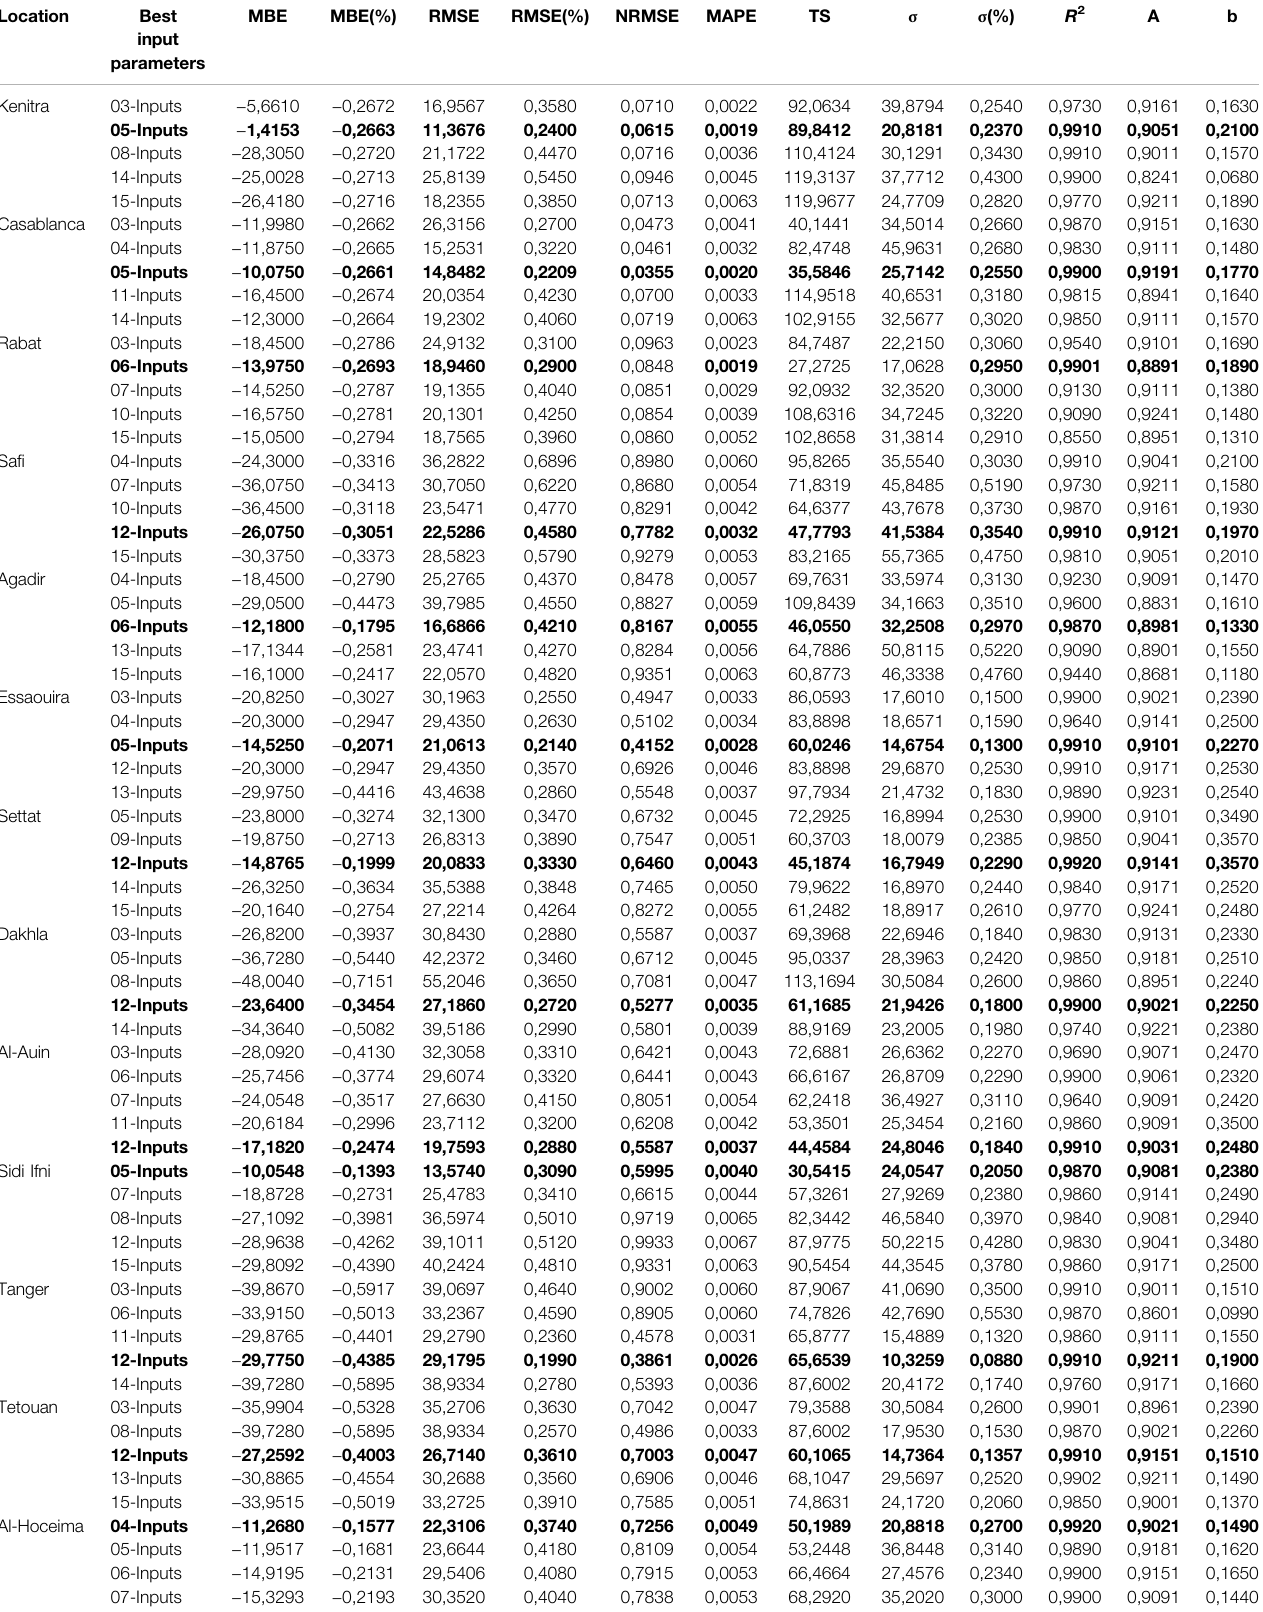
TABLE 5 | Best fi ve inputs parameters of 25 location in Morocco.